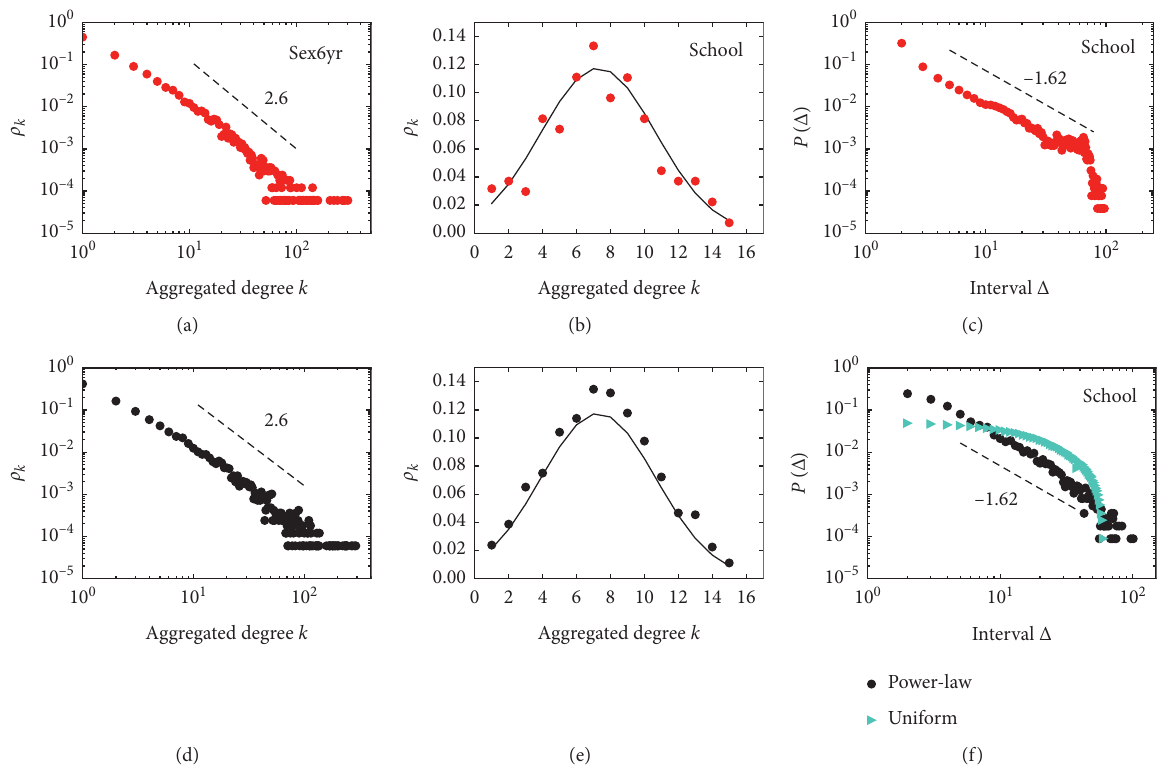
Figure 6: Distributions of the characteristic measures of the real-world networks and memory-driven networks. (a, b) The degree dis- tributions ρ k of the aggregated empirical networks and (d, e) the degree distributions ρ k of the aggregated memory-driven networks. (c, f) The intercontact time distributions P ( Δ ) in the dataset “School,” the memory-driven networks with p ij following a power-law distribution (in black), and the null model with a uniform distribution (in cyan). The synthetic networks are performed with parameters in Table